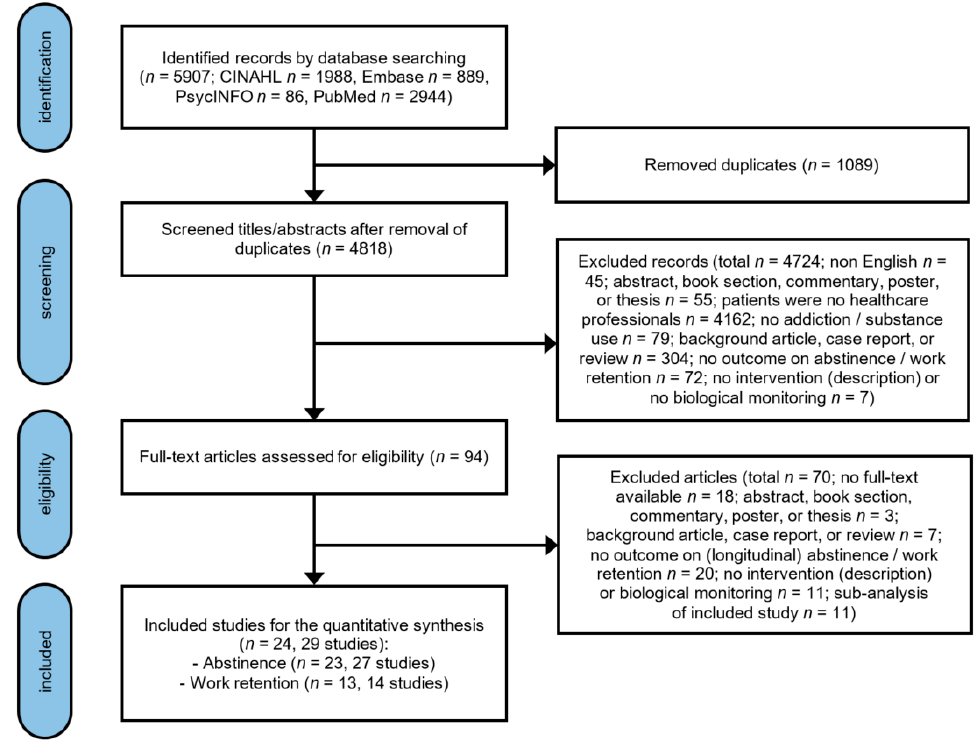
Figure 1. PRISMA flowchart of the selection of studies.